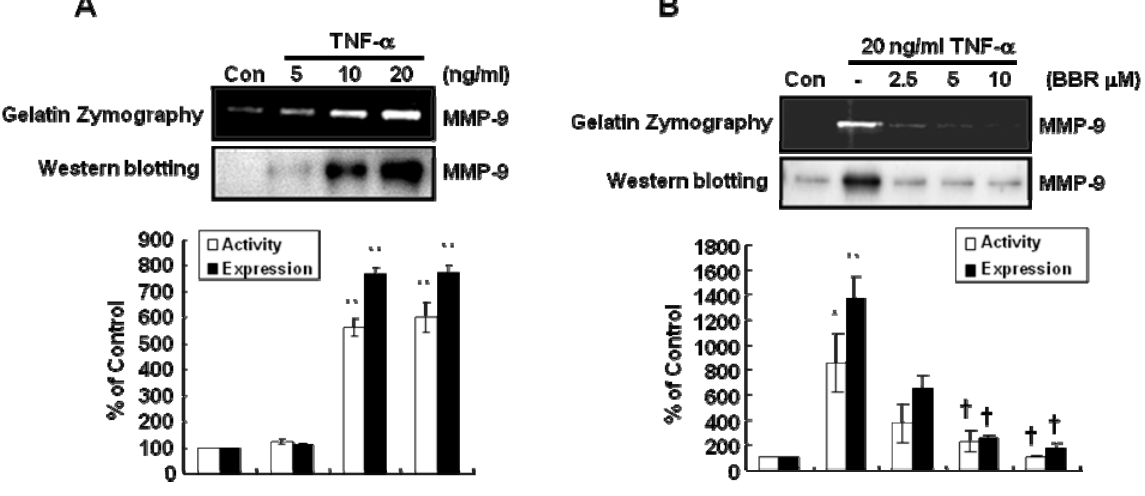
Figure 2. TNF- α -induced MMP-9 activity and expression are dose-dependently decreased by berberine in MDA-MB-231 cells. (A) After serum-starvation for 16 h, cells were treated with TNF- α (20 ng/ml) for 24 h. (B) After serum-starvation for 16 h, cells were pretreated with berberine at the indicated concentration for 1 h and then treated with TNF- α (20 ng/ml) for 24 h. MMP-9 activity and expression were analyzed by Zymography (upper band) and Western blotting (lower band), respectively. These results were representative of three independent experiments. Values shown are means ± SEM. * P < 0.05, ** P < 0.01 vs . control, † P < 0.05 vs . TNF- α -treated cells. Con;